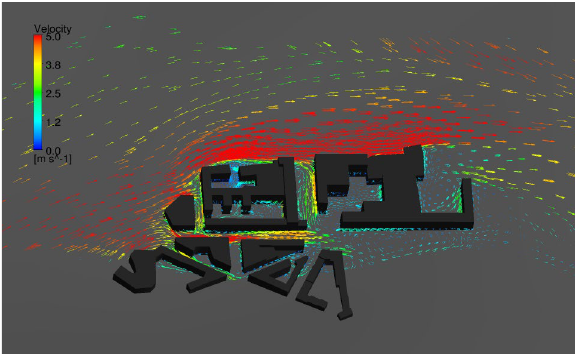
Figure 7. Example of wind velocity at pedestrian level for a building block in Stuttgart. ABL: 3 m/s at 10 m height.